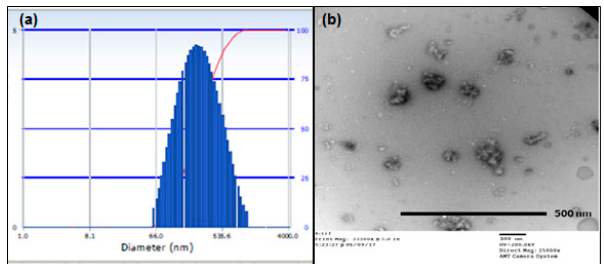
Figure 1. ( a ) Particle size by Dynamic light scattering (DLS) of the hypoxia targeting drug delivery system HSA-PTX-ATZ; ( b ) Particle size and morphology by Transmission electron microscopy (TEM) of the hypoxia targeting drug delivery system HSA-PTX-ATZ.